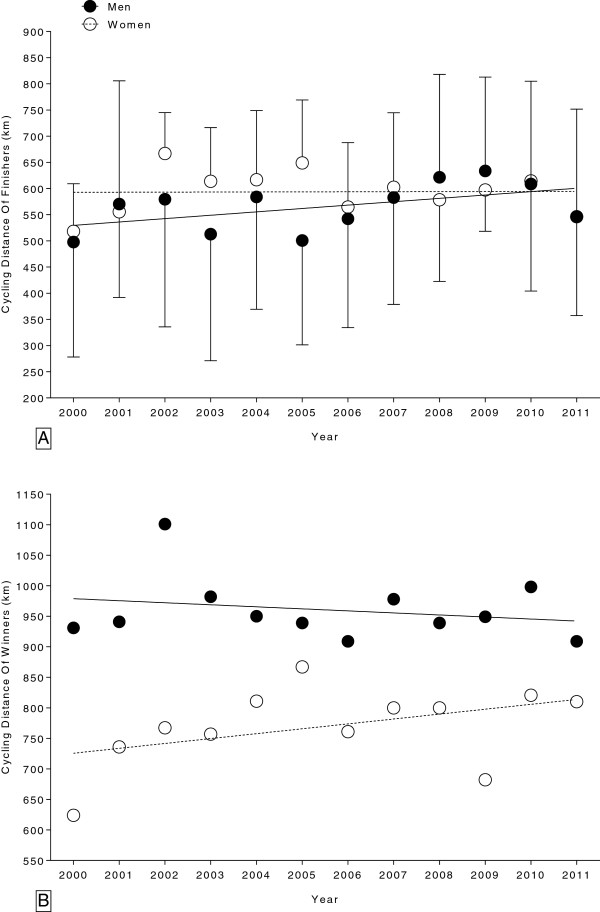
Changes in the cycling distance for all female and male finishers (Panel A) and for the annual winners (Panel B) in the ’24 Stunden Schötz’ from 2000 to 2011.